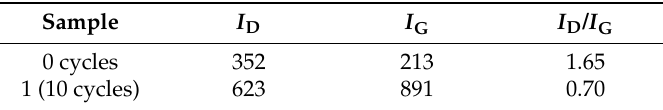
Figure 10. The examples of the fitting spectra using LT10 software.